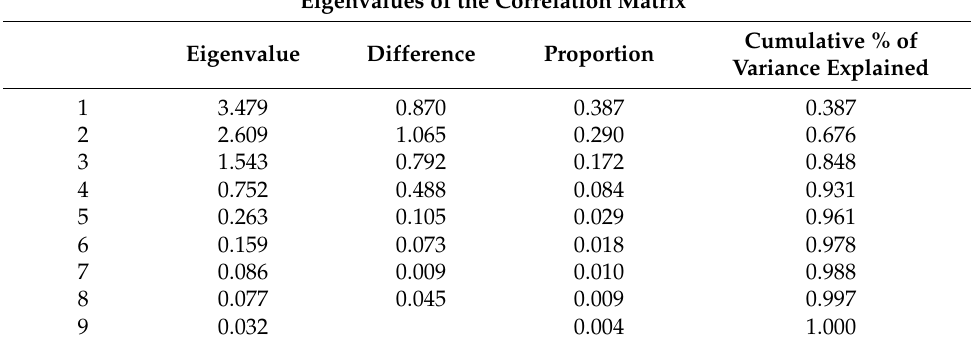
Table 3. Eigenvalues of the correlation